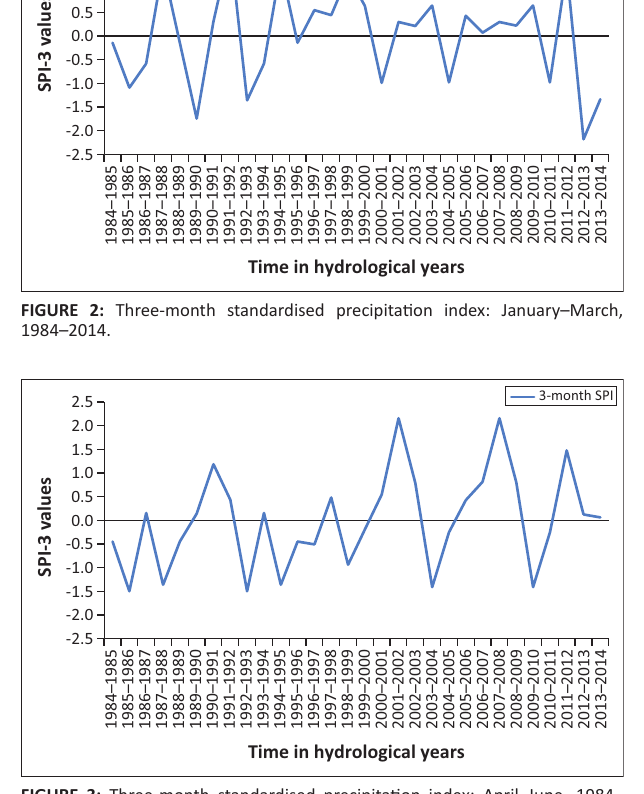
FIGURE 5: Three-month standardised precipitation index: October–December,